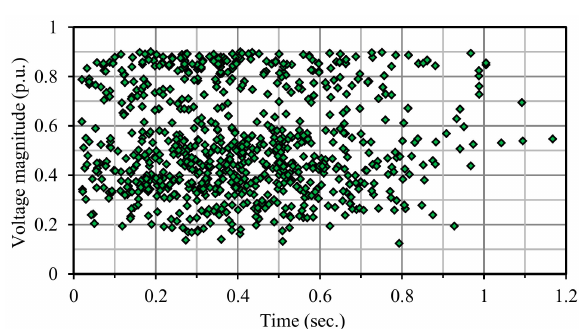
Figure 8. SD associated with load point 55.